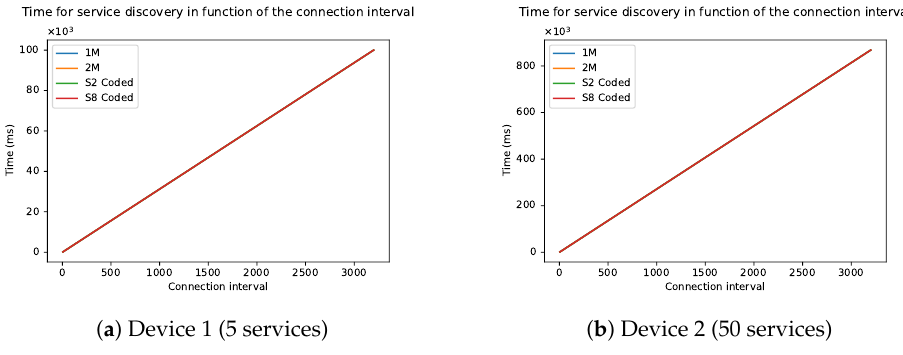
Figure 10. Time of the discovery process as a function of the connection interval of two devices: ( a ) Device 1 and ( b ) Device 2.